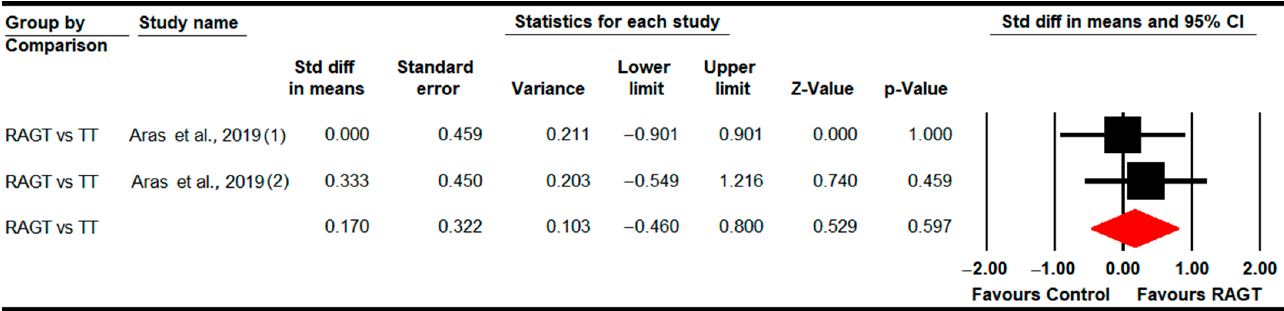
Figure 4. Forest Plot of Step width (Post-Intervention Assessment) [85,88].